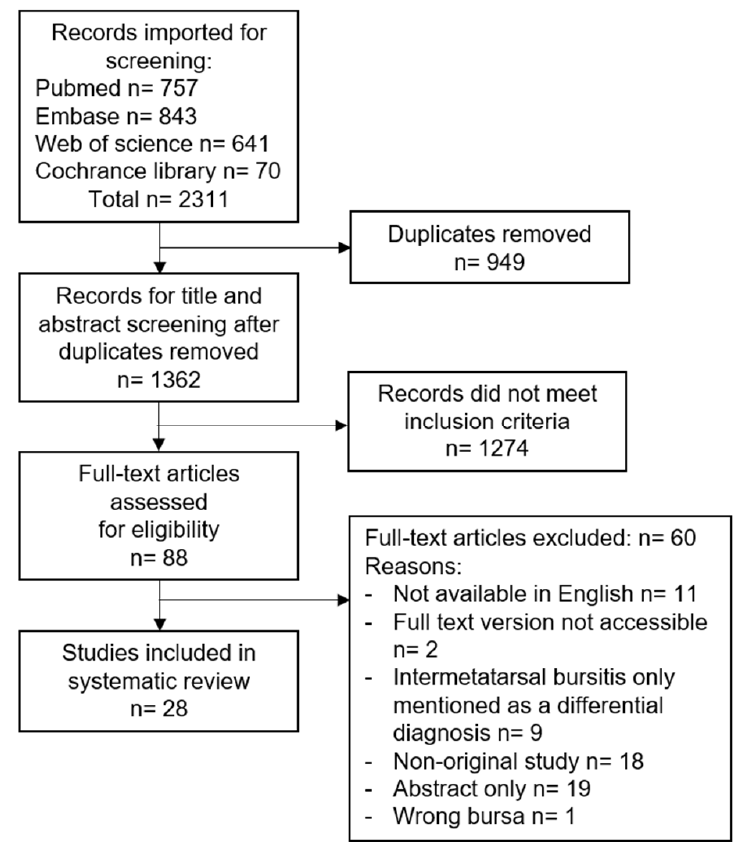
Figure 1. Review process